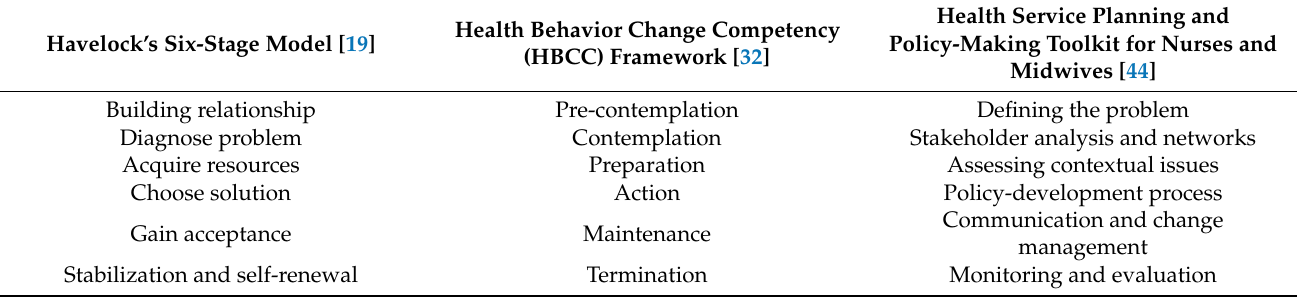
Table 1. Change models for healthcare